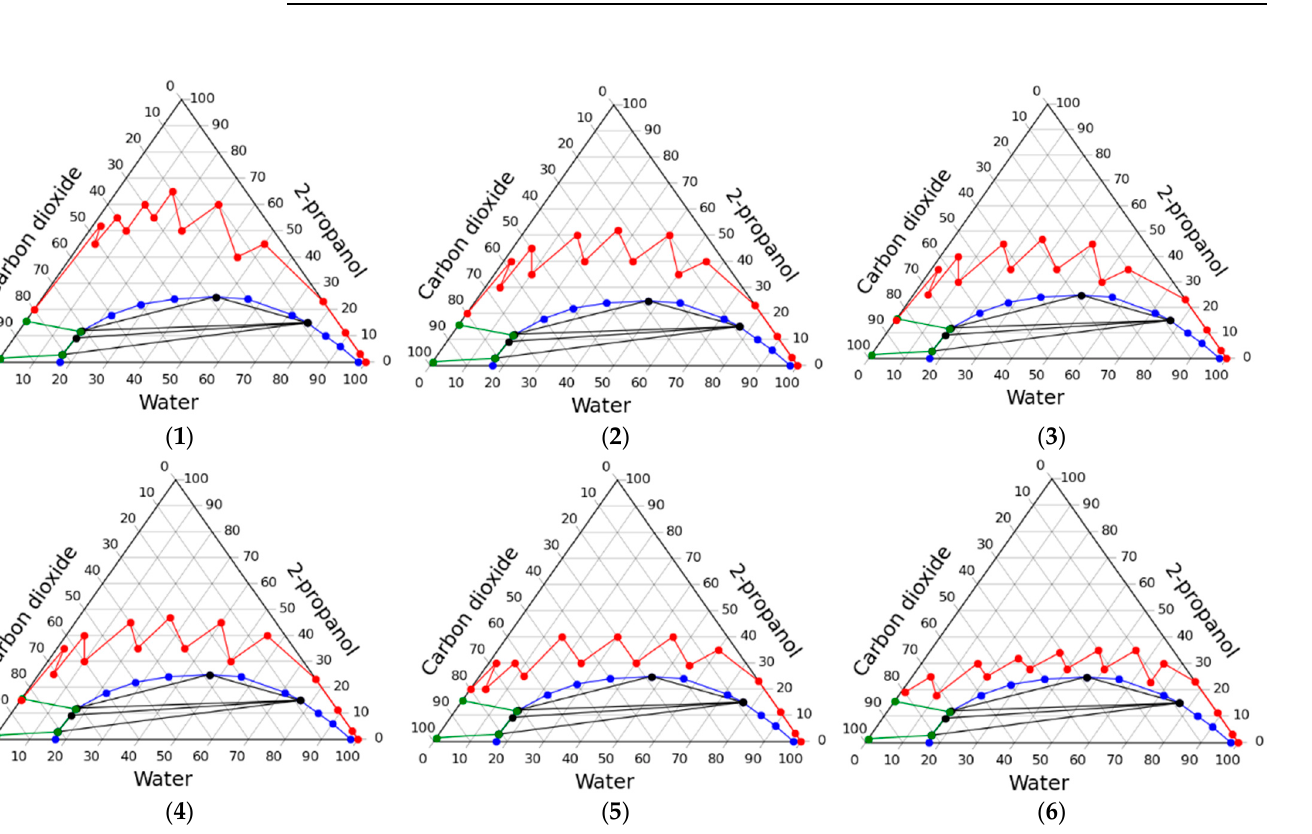
Figure 5. Intensification of the solvent exchange under high pressure at carbon dioxide medium: operating line examples.